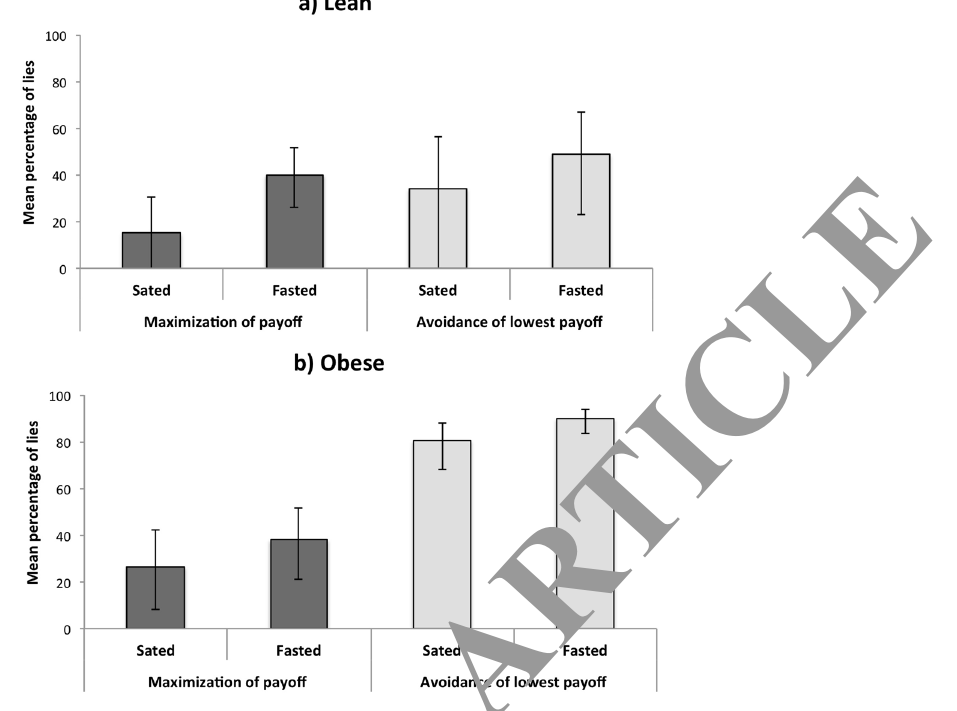
Figure 2. Estimated mean percentage of lies motivated either by payoff maximization or by avoidance of the lower payoff, under the Sated and Fasted Conditions. Panel ( a ) is for lean subjects and panel ( b ) for obese subjects. Bars indicate 95% confidence